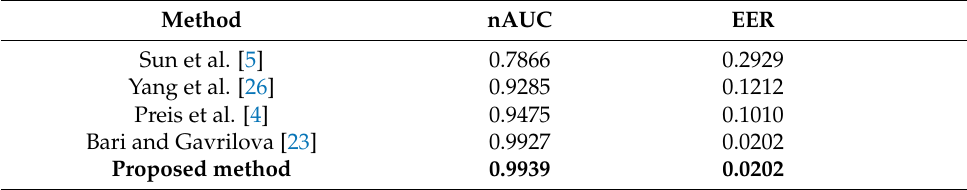
Table 7. nAUC and EER of the proposed method and the prior works on the UPCV dataset. The best performance is shown in bold.